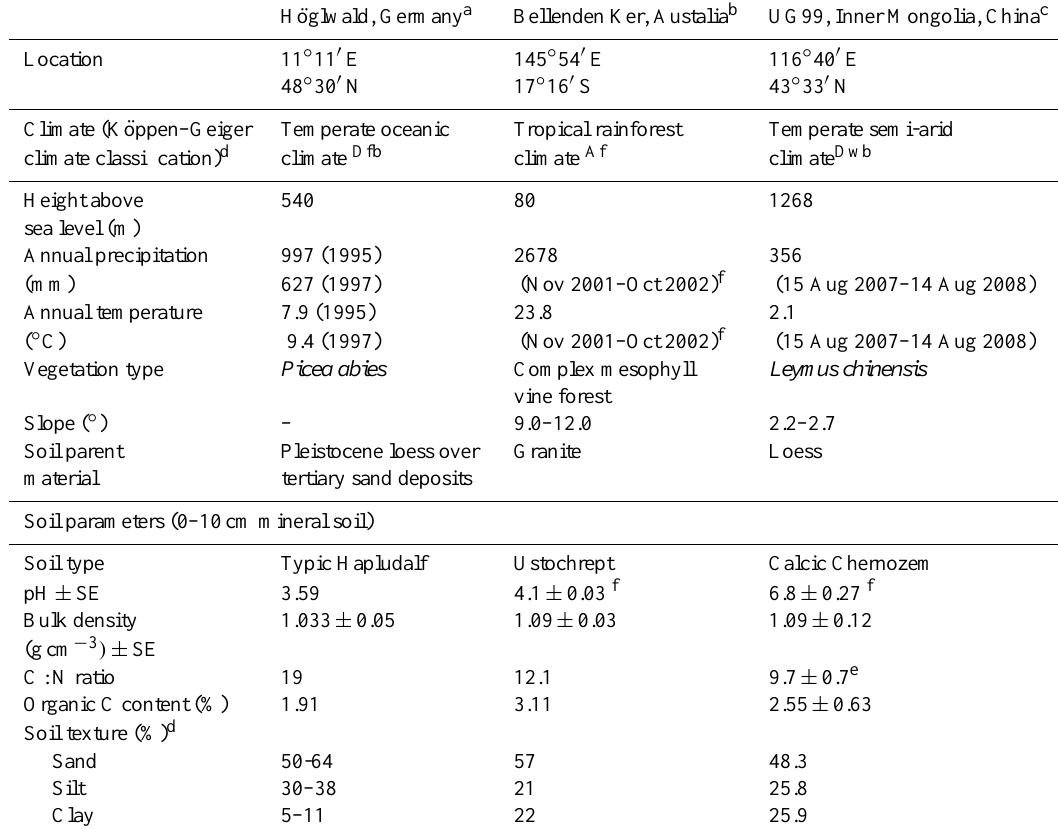
Table 1. Main characteristics of the different measuring